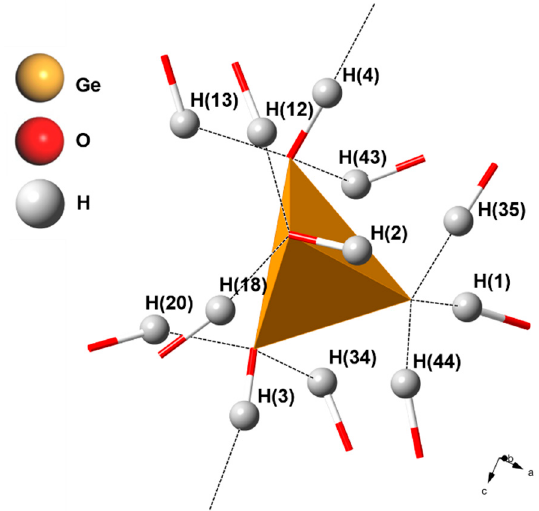
Figure 4. The optimized hydrogen bonds structure surrounding the newly proposed Ge-tetrahedra in tunnel site of Ge- akagan é ite model after density functional theory with dispersion correction (DFT-D) calculation. Hydrogen bond lengths are summarized in Table 4. Hydrogen bonds are represented as dashed lines. Corner oxygens have conjugation bonds with three hydrogens and each hydrogen also has a conjugation bond with corner oxygen and structural oxygen.